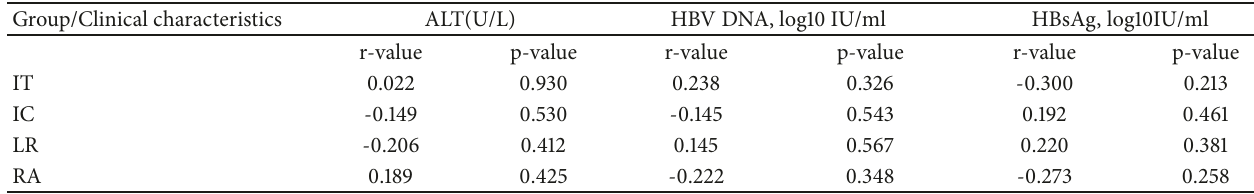
Table 3: Correlations between frequency of CCR 7 lo PD- 1 hi CXCR5 + CD4 + T cells and clinical characteristics in 4 subgroups of patients with chronic HBV infection.